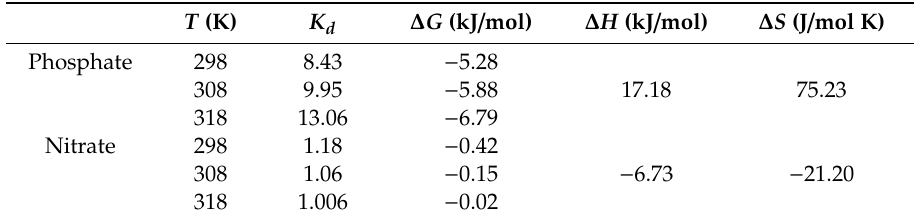
Table 6. Thermodynamic parameters for phosphate and nitrate adsorption onto B 5 MgAl composite. T (K) K d ∆ G (kJ / mol) ∆ H (kJ / mol) ∆ S (J / mol